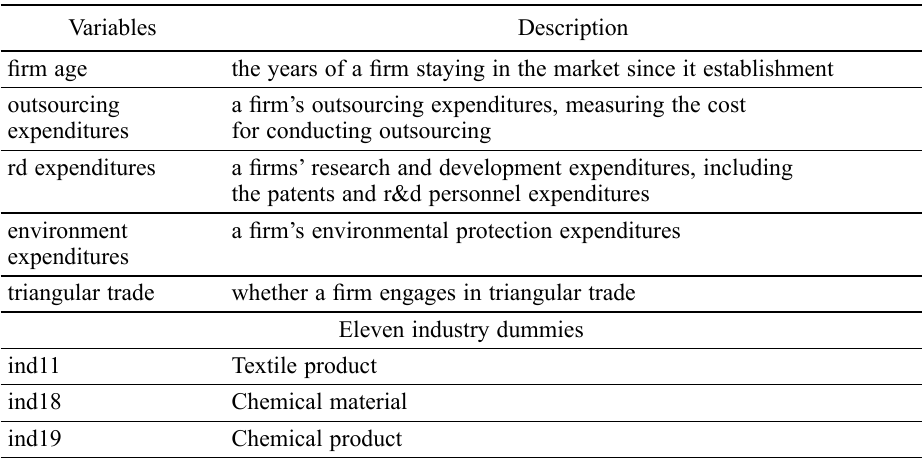
Table 1. Variables